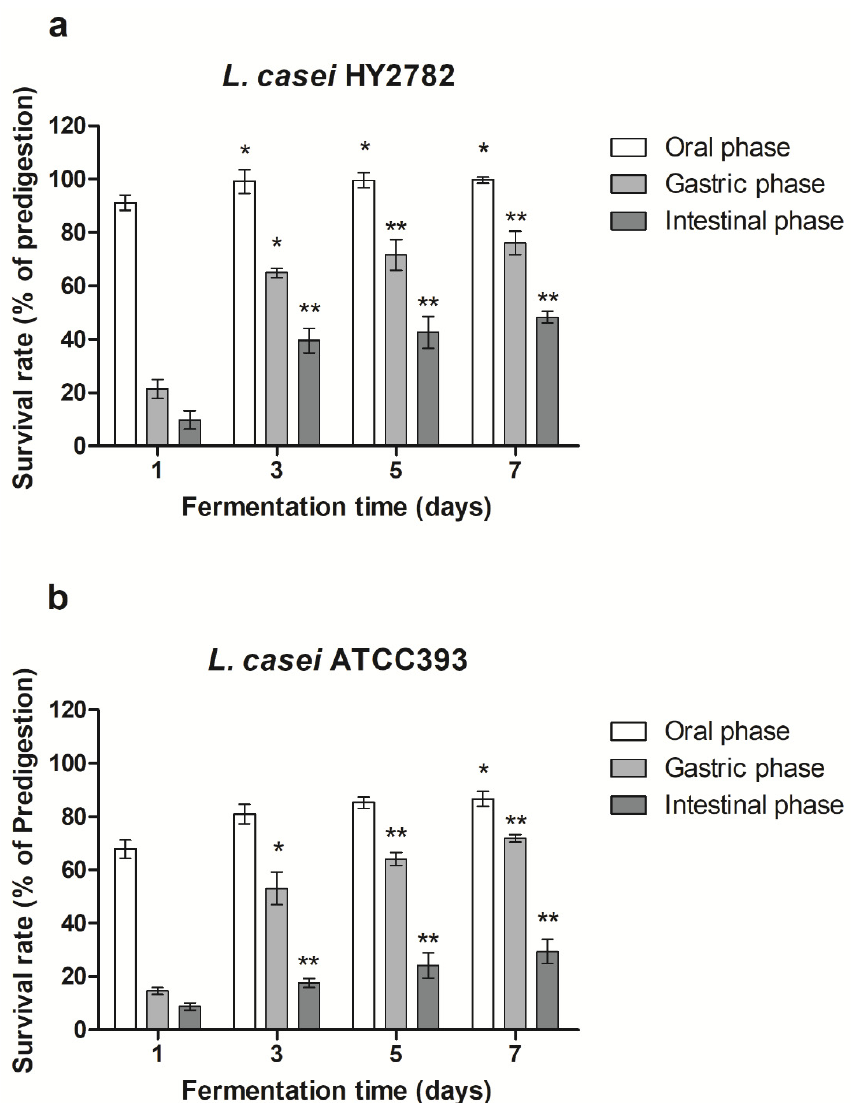
Figure 2. Survival rate during simulated gastrointestinal digestion of fermented milk with Lacto- bacillus casei HY2782 ( a ) or L. casei ATCC393 ( b ). Different letters above the bars indicate statistically significant differences from each stage on day 1 of fermentation (* p < 0.05, ** p < 0.01).